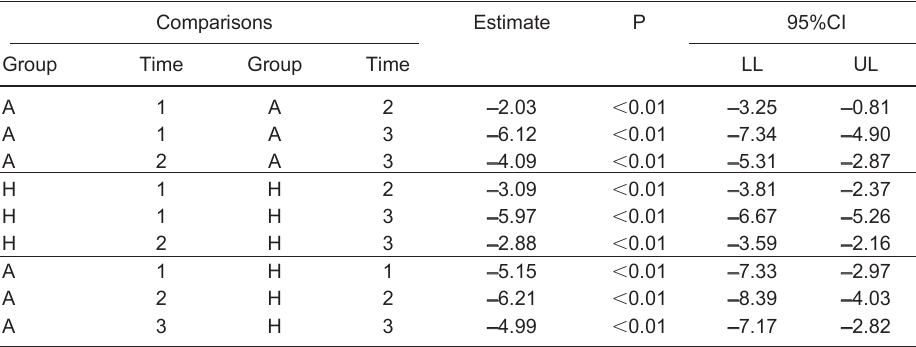
Table 2. Results of group comparison at the various times using a mixed-effects linear